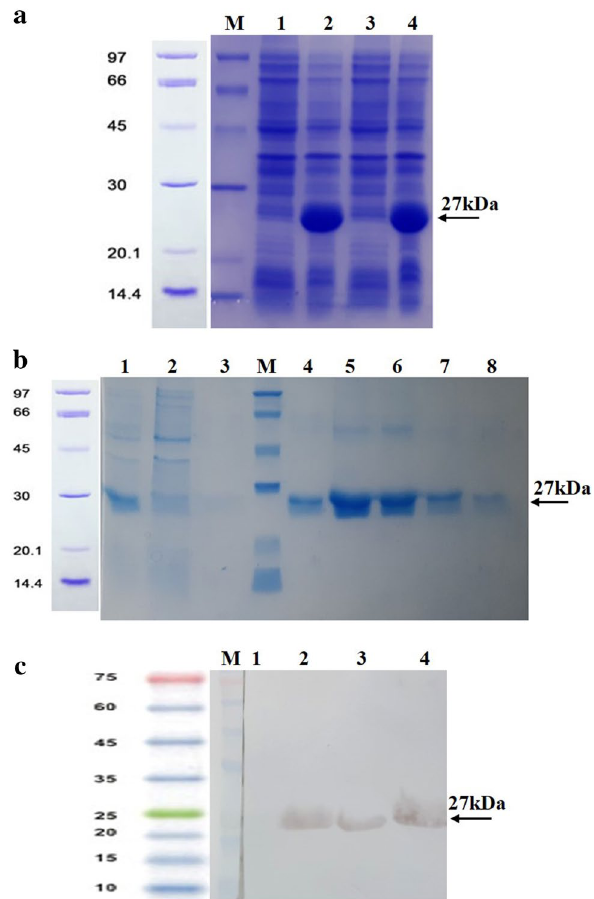
Figure 2. ABD-GCSF protein. (a) Protein expression: M: Protein Mw marker; #1, 3: Recombinant bacterial lysates before induction; #2, 4: Recombinant bacterial lysates after induction. (b) Protein purification: #1: Initial sample (IS); #2: Flow through (FT) sample; #3: Washing sample; M: Protein Mw marker; #4–8: Eluted samples. (c) Western blotting: M: Protein Mw marker; #1, 2: Bacterial lysates before and after induction; #3, 4: Eluted proteins. The full-size original gels and the blot are presented in supplementary Fig. S1a,b,c,